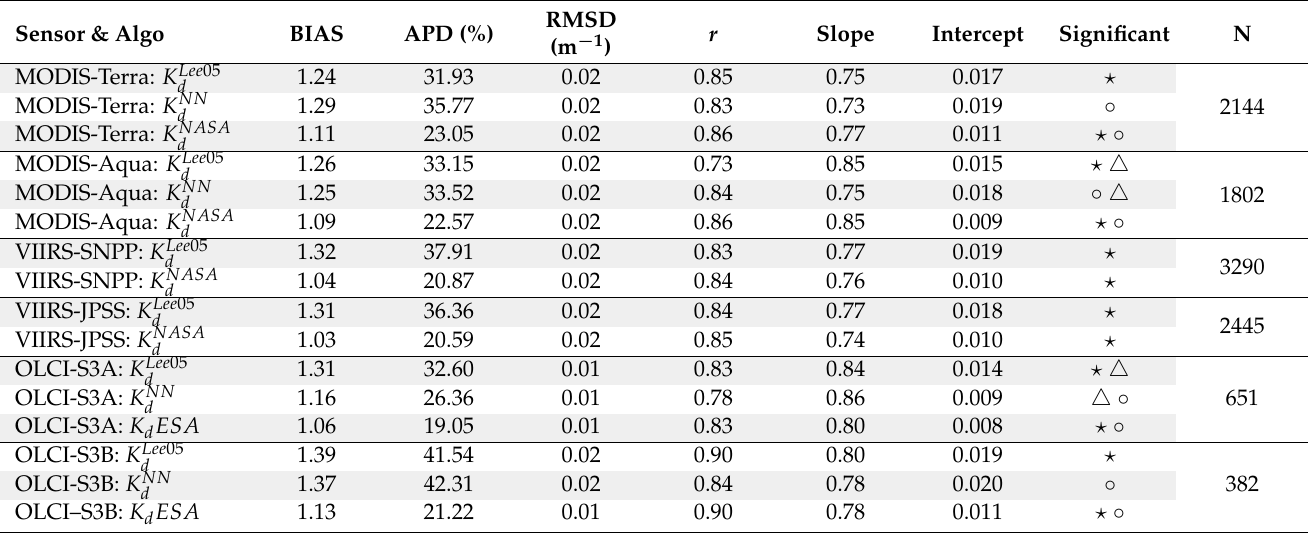
Table 3. Comparison of performance statistics at the global scale of the K d (490 nm) algorithms; (cid:63) denotes a statistically significant difference between K Lee 05 and K NASA / ESA ; (cid:52) a statistically d d significant difference between K Lee 05 and K NN ; and ◦ a statistically significant difference between d d K NN and K NASA / ESA . See Methods section for definitions of statistical performance metrics. d d